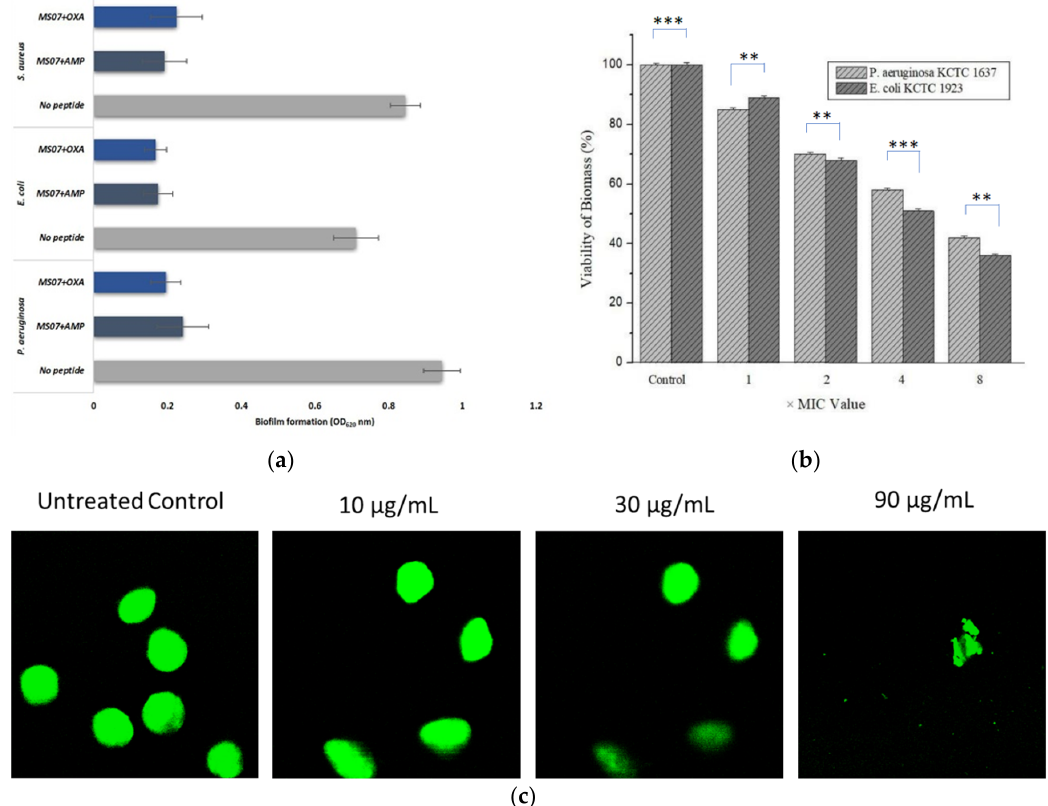
Figure 6. ( a ) Bacteria treated with a combination of MS07 and oxacillin (MS07 + OXA); combination of MS07 and ampicillin (MS07 + Ampicillin; to verify biofilm development, microbial cells in MH broth accompanied by 0.2% glucose were placed in TCPs 96 well plates and incubated for 24 h at 37 °C; the results are presented as the mean ± the standard deviation. ( b ) The viability of Pseudomonas aeruginosa and Escherichia coli biofilm was decreased after 24 h at an elevated concentration of peptide MS07. ANOVA test, *** p ˂ 0.001, ** p ˂ 0.01, * p ˂ 0.05. ( c ) Effect of MS07 on Pseudomonas aeruginosa